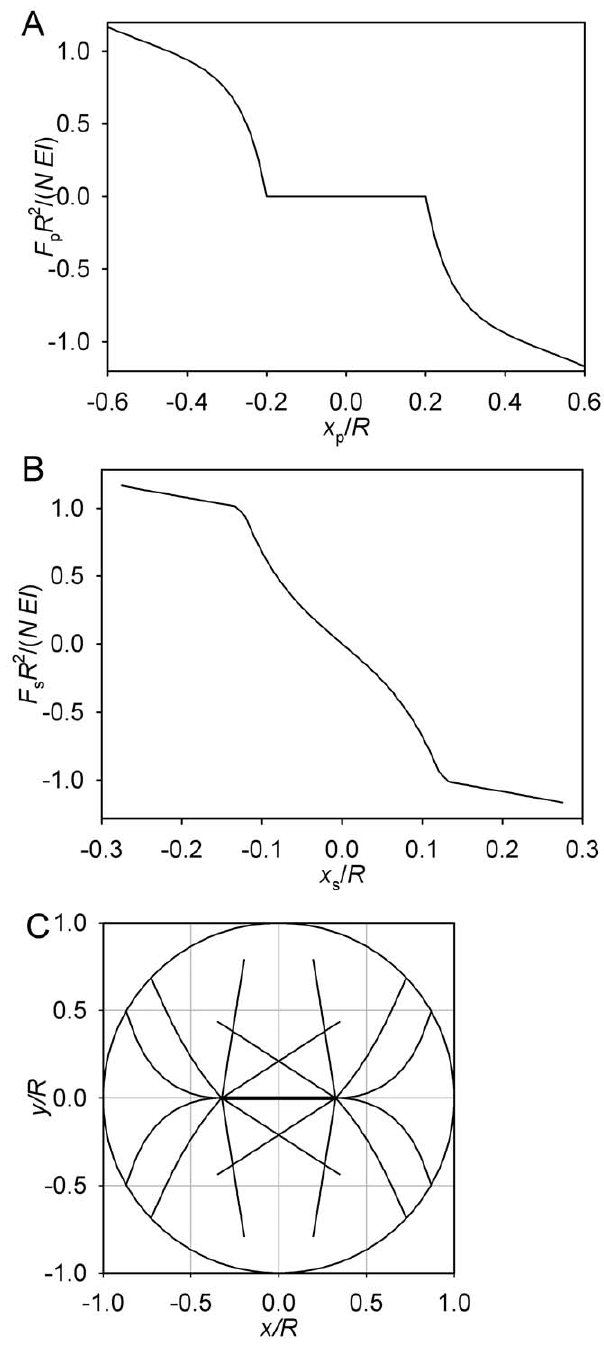
Figure 3. Limiting case of h max = p , short microtubules. (A) Pole force function. (B) Spindle force function. (C) Equilibrium conformation. L =0.8 R , S =0.65 R . For clarity, few microtubule forms are plotted. These microtubules lie in the ( x , y ) plane that passes through the spindle axis. Their values of h are sampled uniformly between 0 and h max . doi:10.1371/journal.pone.0038921.g003 from the pole force function extremum, and the other occupies a position toward the cell margin from that pole’s extremum. With furthergrowthof h max ,theasterincreasesresistanceatmoreeccentric pole positions (Fig. 5A, dashed curve). This eventually erases the nonmonotonicity of the pole force function. Fig. 5A shows that for